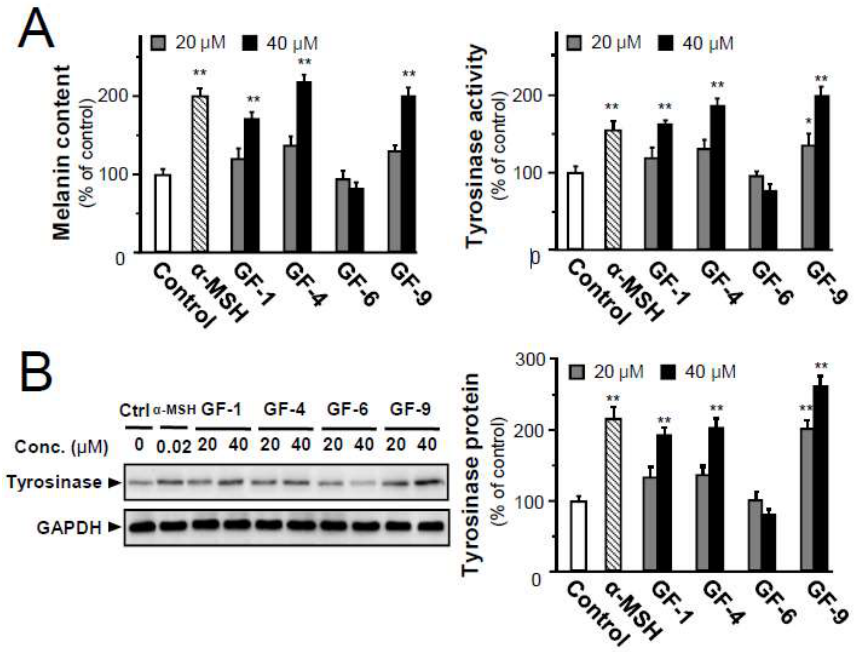
Figure 4. The G. uralensis flavonoids induce the amounts of melanin content, tyrosinase activity, and tyrosinase expression of B16-F10 melanoma cells. ( A ) B16-F10 cells were treated with indicated concentrations of selected flavonoids (GF-1, 4, 6, and 9) or with α-MSH at 20 nM for 48 h. The amounts of melanin (left panel) and tyrosinase activity (right panel) were determined. ( B ) The level of tyrosinase protein (~91 kDa) in the melanoma cells was measured by Western blot (left panel). The amount of tyrosinase was qualified against GAPDH (~37 kDa) (right panel). Data are expressed as percentage of control, in means ± SEM ( n = 3). * p < 0.05, ** p < 0.01, compared with control.